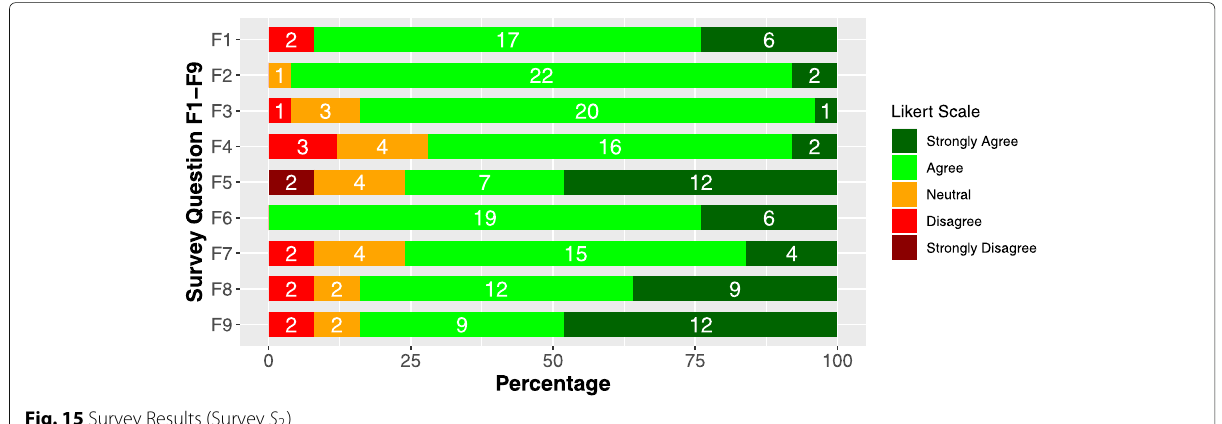
Fig. 15 Survey Results (Survey S 2